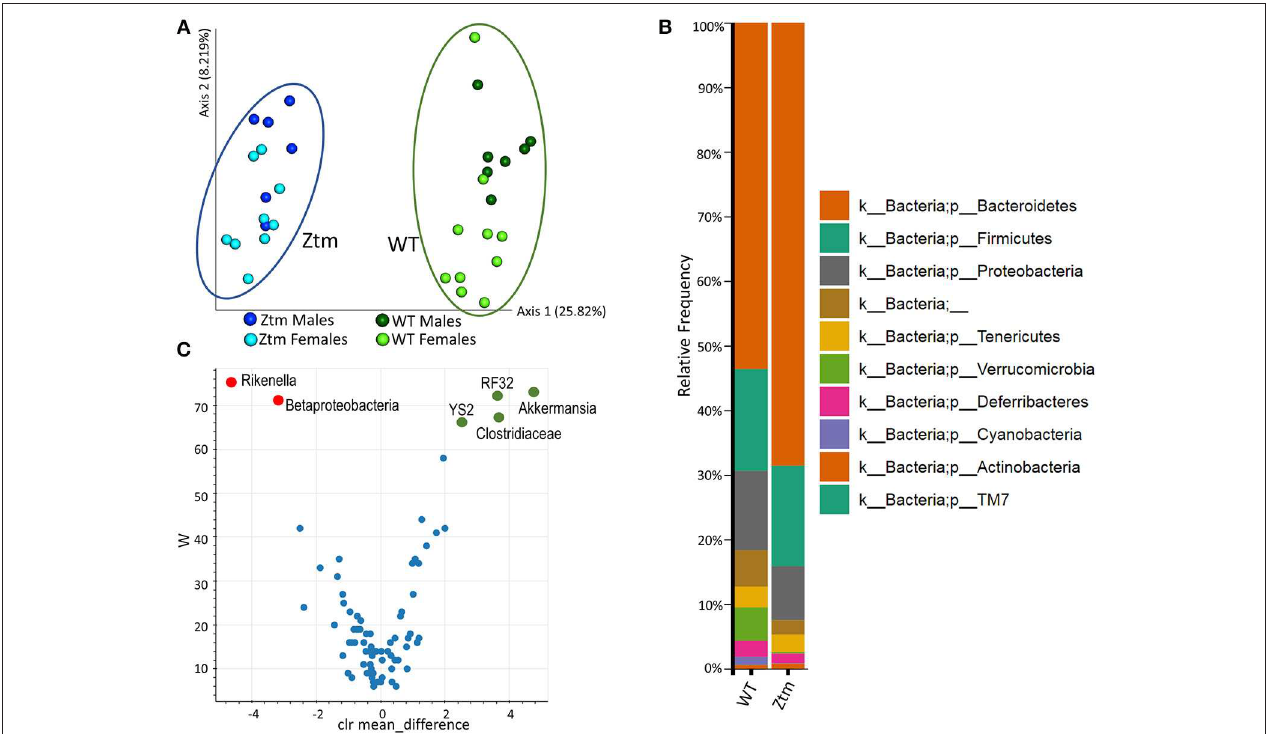
FIGURE 3 | Baseline dysbiosis in Ztm gut microbiota. Stools from 15 WT mice (WT males n = 6, WT females n = 9) and 17 Ztm (Ztm males n = 7, Ztm females n = 10) were analyzed. (A) Principal Component Analysis (PCA) of Jaccard distances for Ztm ( n = 17) and WT ( n = 15) mice show distinct clustering between Ztm and WT. No significant differences between males and females within each group were detected. (B) Microbiota composition at phylum level. WT ( n = 15), Ztm ( n = 17). Males and females within each group were analyzed together. Absence of Verrucomicrobia and Cyanobacteria in the Ztm is evident. (C) Volcano plot showing the statistical differences between Ztm and WT at genus level. In green overrepresented genus in WT mice, in red overrepresented genus in Ztm. Differential abundance analysis of OTUs was performed using ANCOM. Statistical significance was tested by the Kruskal-Wallis of abundance differences, with the multiple testing corrections using Benjamini-Hochberg false discovery rate (FDR) set at